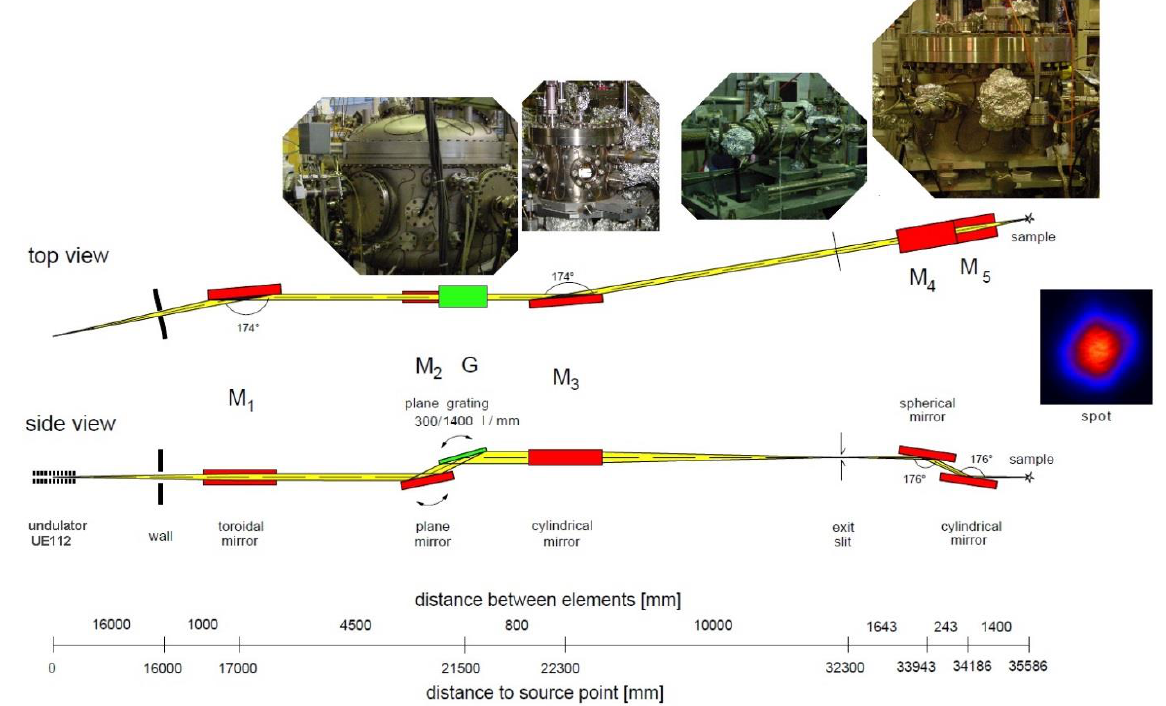
Figure 1: The optical layout of beamline